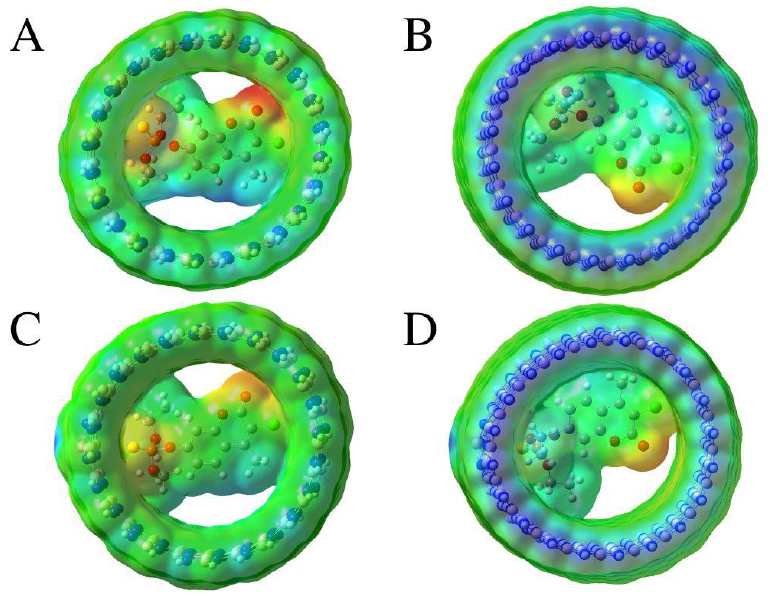
Figure 3. Electrostatic potentials of ( A ) BNNT(12,12) + cou, ( B ) BNNT(20,0) + cou, ( C ) Al-BNNT(12,12) + cou, and ( D ) Al-BNNT(20,0) + cou.